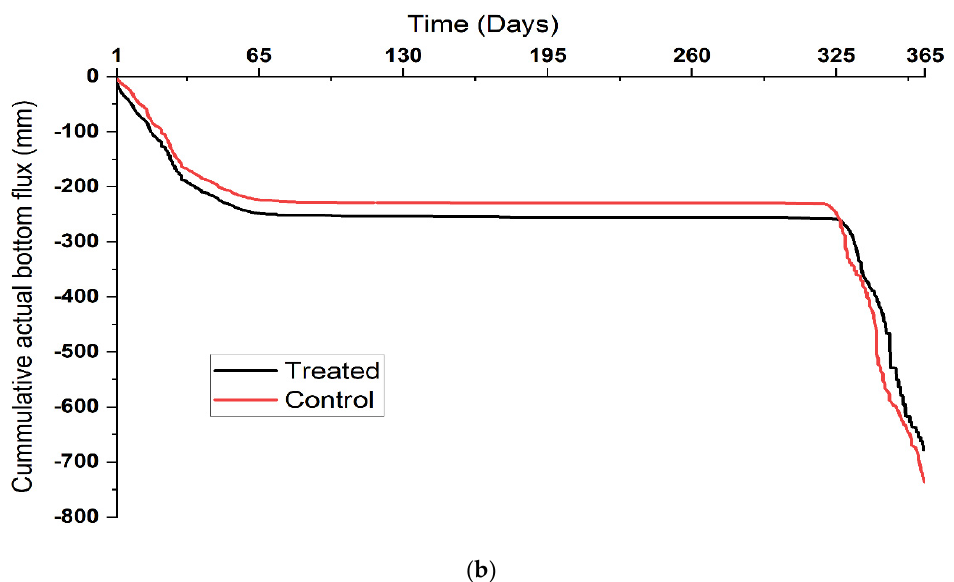
Figure 3. Soil water storage under treated versus control cultivated land on gentle slope ( a ), Cumulative bottom flux under treated versus control cultivated land on gentle slope ( b ).